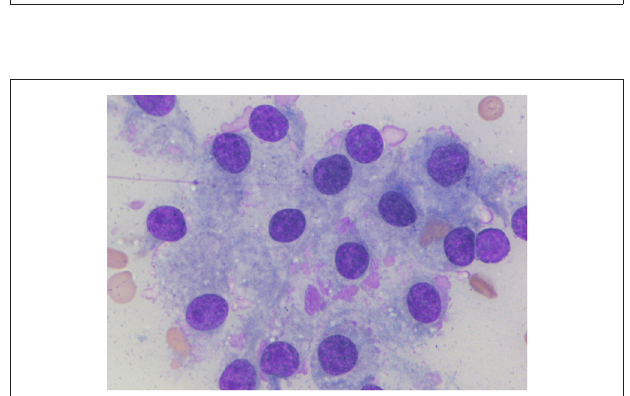
FIGURE 2 | Cytological findings of the goiter caused by iodine deficiency in the dog. Microscopic analysis shows that the cells are polygonal in shape with or without an intercellular border. Nuclei are eccentrically located and have a mild coarse chromatin pattern with basophilic nucleoli. Additionally, there is a low nucleus-to-cytoplasm ratio. Wright-Giemsa.